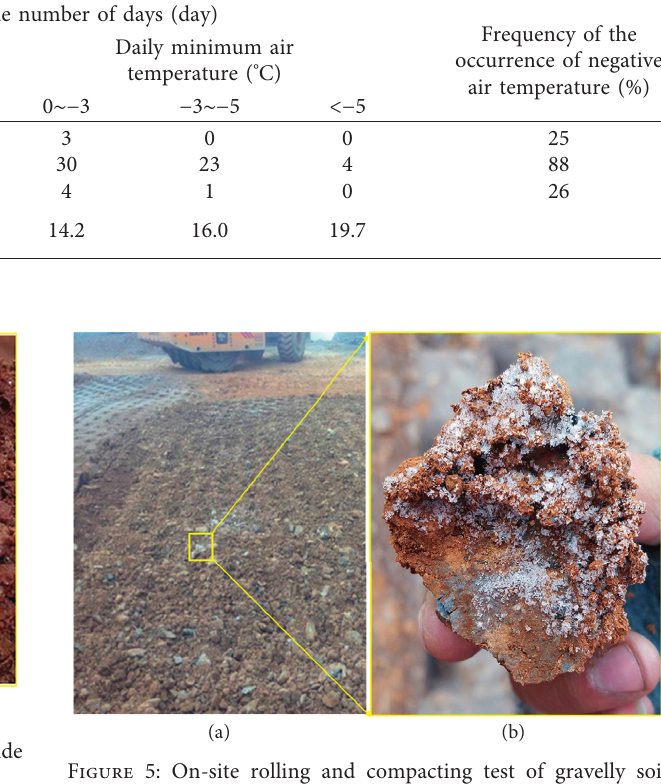
Table 1: Statistical results of air temperature and the maximum frozen depth of the compacted gravelly soil without covering the thermal insulation materials.